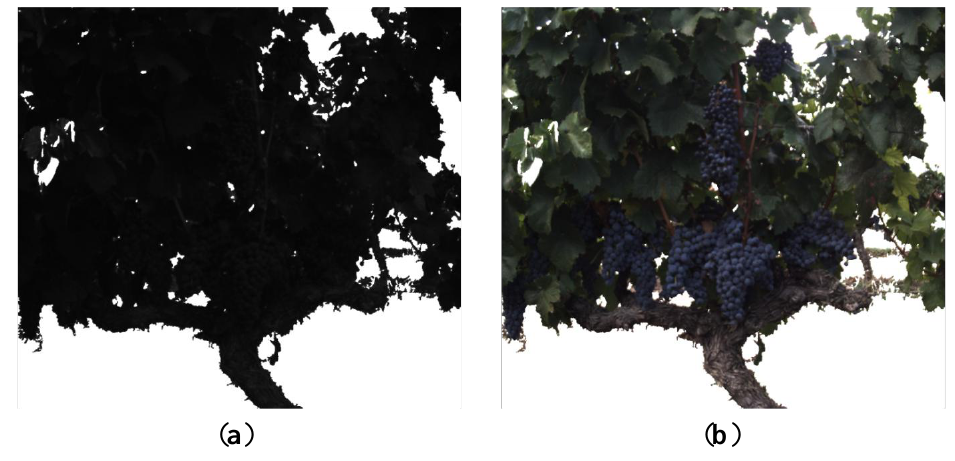
Figure 7. Steps 2–3. ( a ) Background mask (mask 1) obtained after morphological procedure; ( b ) RGB image with background mask.